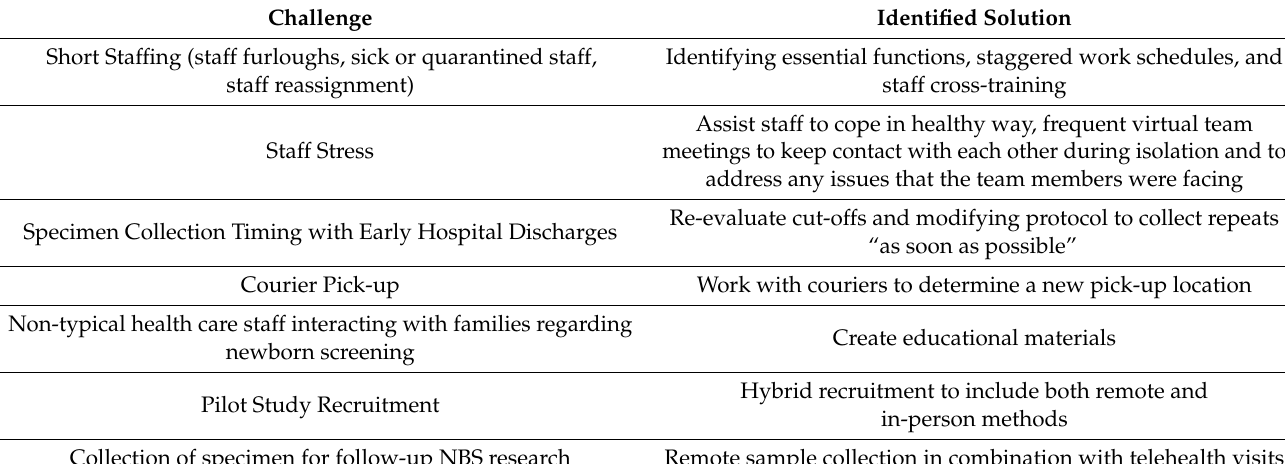
Table 1. Common Challenges faced by state NBS programs during the COVID-19 Pandemic and Identified